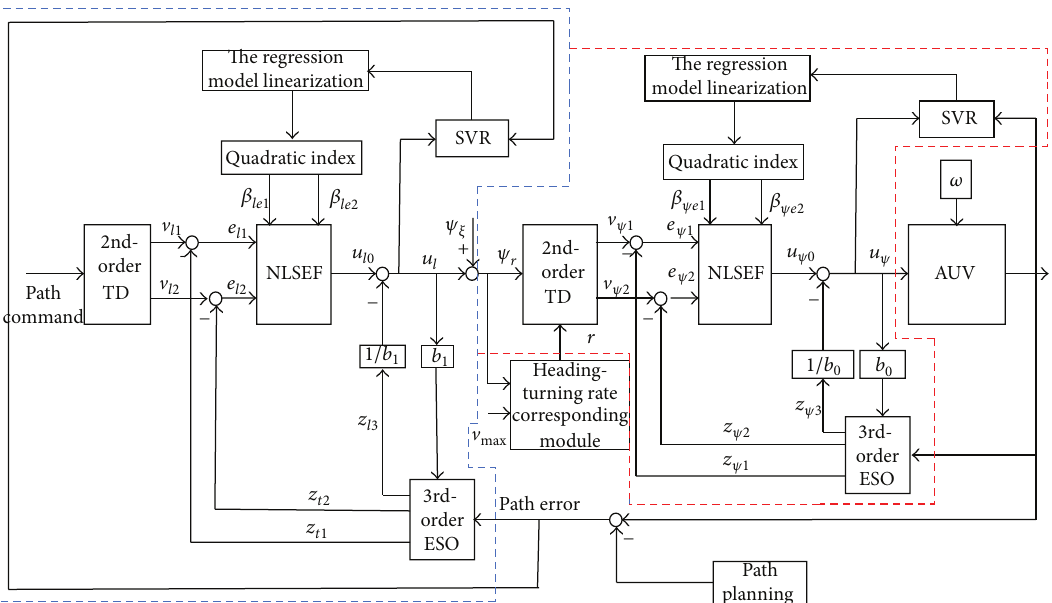
Figure 3: The architecture of path following